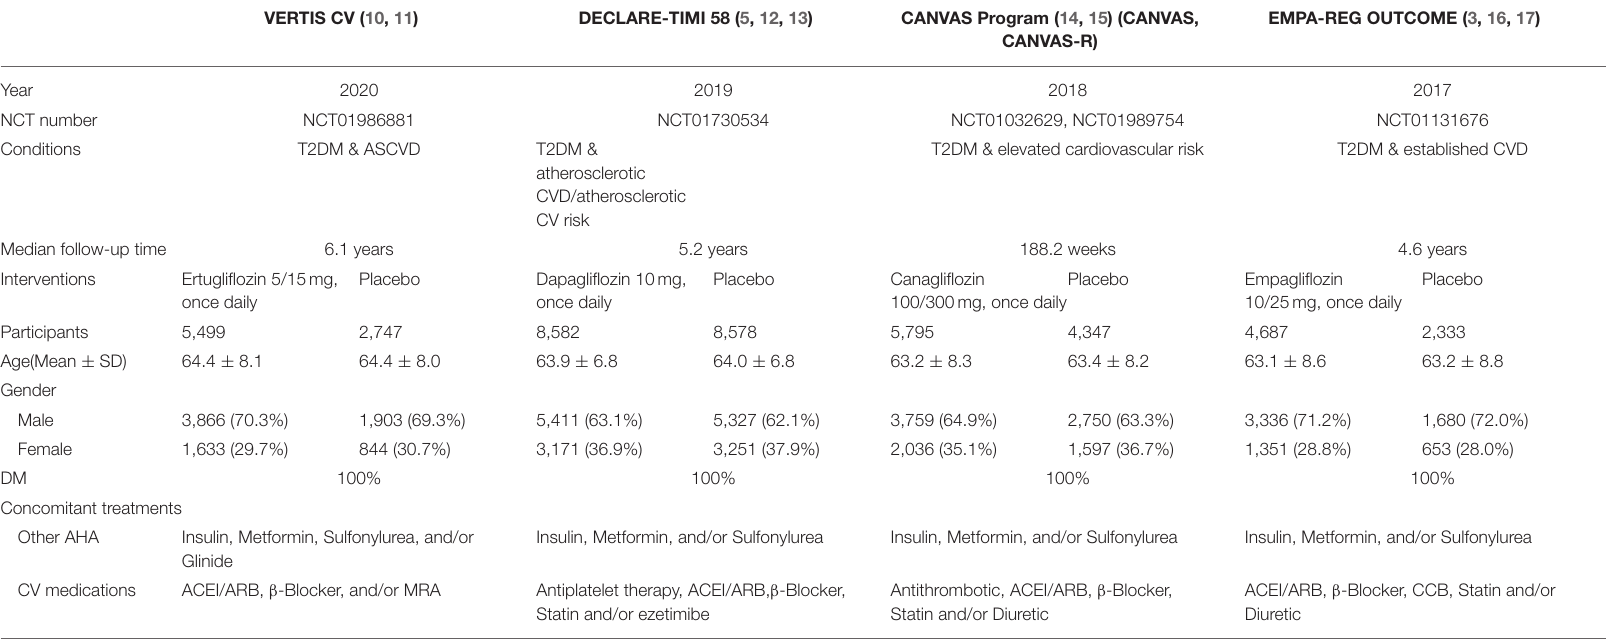
TABLE 1 | An overview of the main characteristics of the four trial populations at the